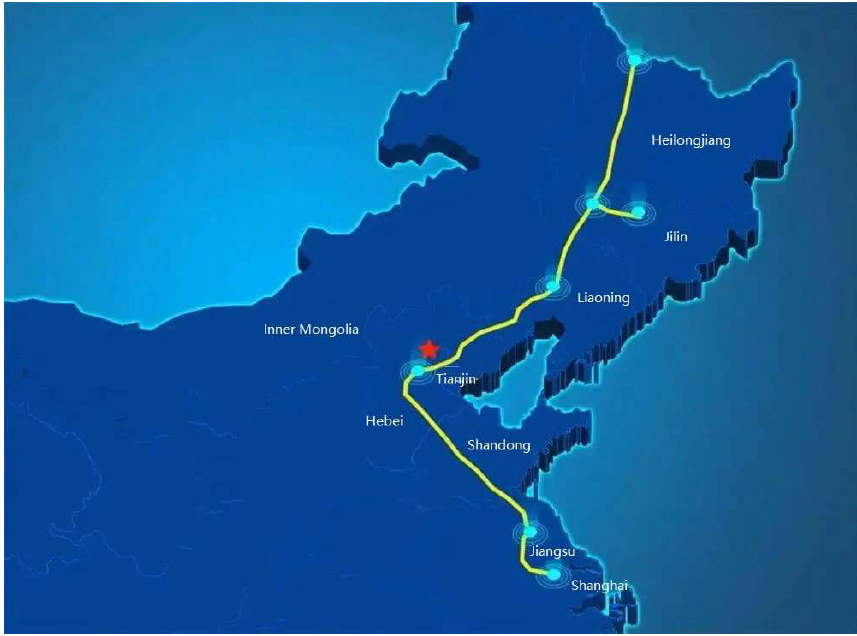
Figure 1. The overall route map of the China–Russia East-Route pipeline.